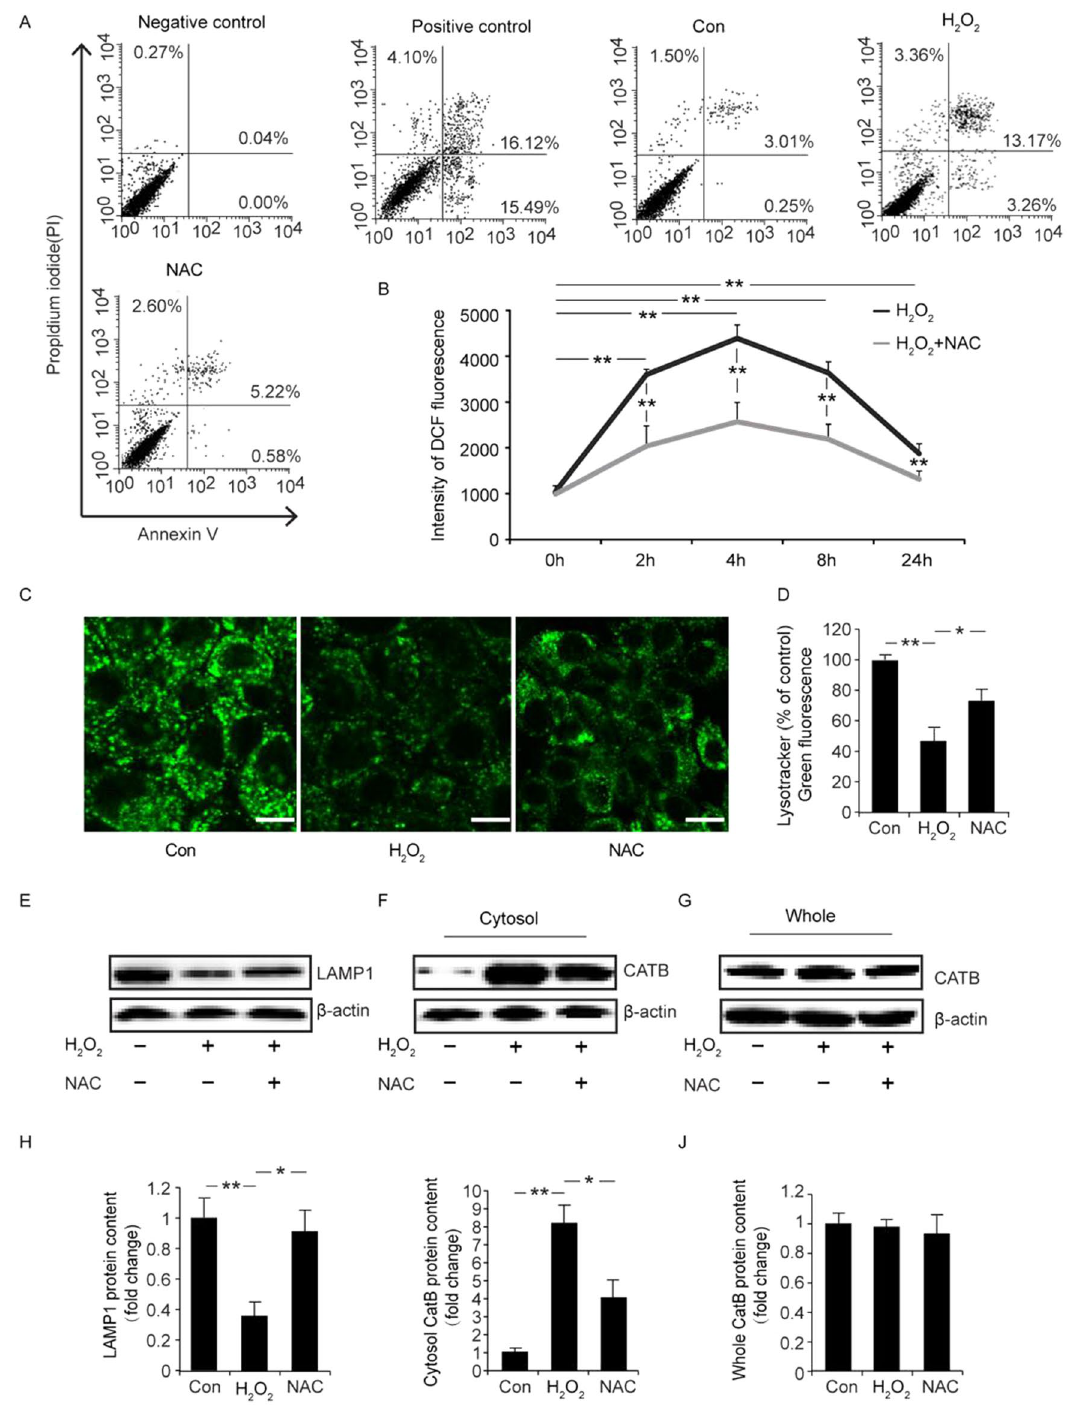
Figure 8. Effect of NAC on ROS content, cell death, lysosomal membrane permeability and the leakage of CatB to the cytosol. To identify the effect of NAC in vitro, cells were treated with 100 μg/ml of NAC for 12 h followed by an additional 2 h with 500 μM H 2 O 2 for the assay with FACS. For the ROS content assay, the cells were treated with 100 μg/ml NAC for 24 h followed by 500 μM H 2 O 2 for different amounts of time. In other assays, the cells were treated with 100 μg/ml NAC for 16 h followed by an additional 8 h with 500 μM H 2 O 2 . ( A ) The Annexin V/PI assay with FACS is shown. ( B ) The ROS contents in cells is shown. ( C ) LysoTracker Green staining (scale bar = 10 μm) is shown. ( D ) Quantification of the LysoTracker Green staining is shown. ( E, H ) Levels of LAMP1 protein were measured in cells by Western blotting and quantification is shown. ( F, G, I, J ) Cat B/D levels were measured in the cytosol/whole lysate by Western blotting and the quantification is shown (*p < 0.05, **p <